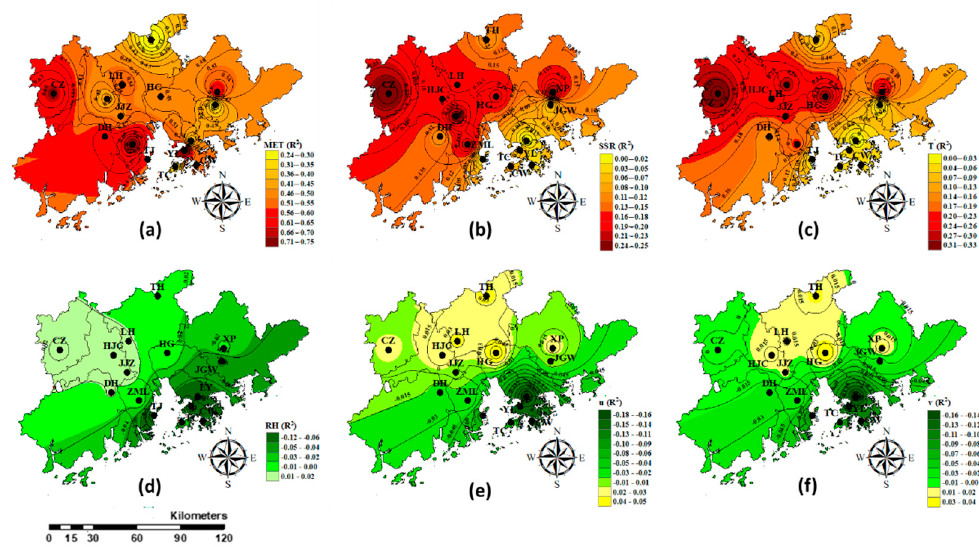
Figure 6. Coefficients of determination (R 2 ) between the baseline of Maximum daily 8-h moving averages (MDA8) and baselines of meteorological variables from 2007 to 2018 ( a – f ) is R 2 between O 3 and all the five meteorological factors (MET), total net surface solar radiation (SSR, c ), daily maximum 2-m temperature (T, b ), daily minimum relative humidity (RH, d ), 10-m mean wind (u, e and v, f )